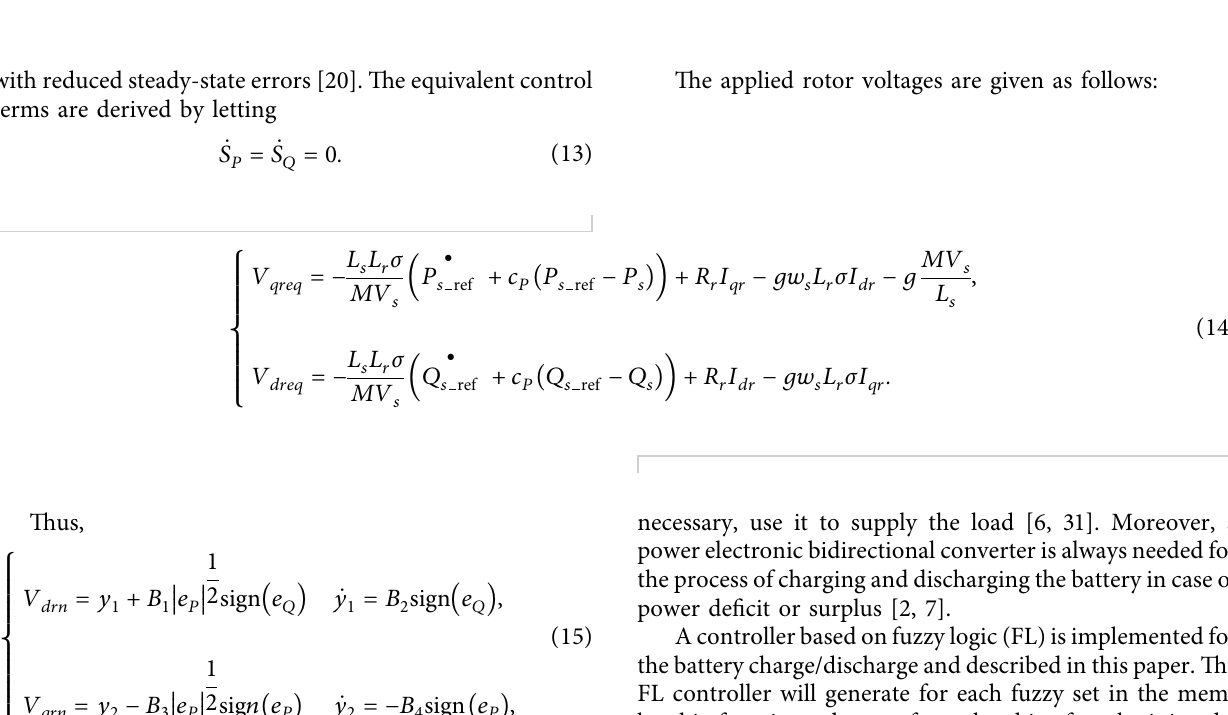
Figure 13: Reactive